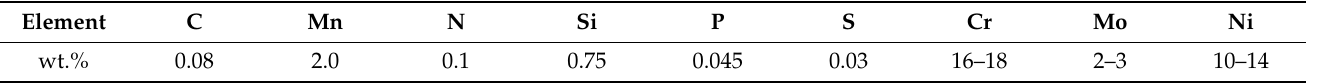
Table 1. Chemical composition of workpiece